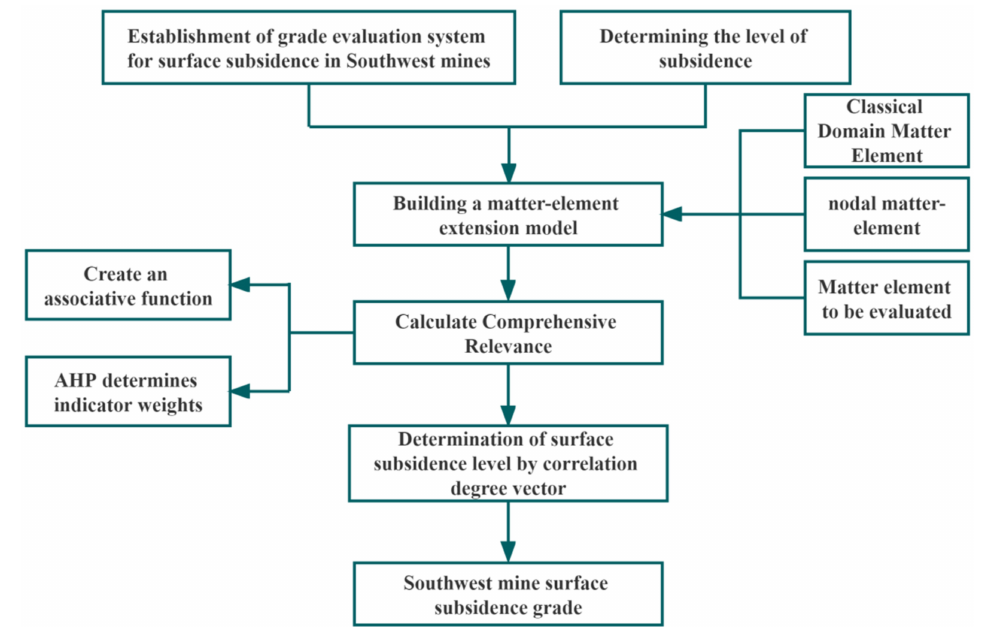
Figure 2. Mine surface subsidence evaluation